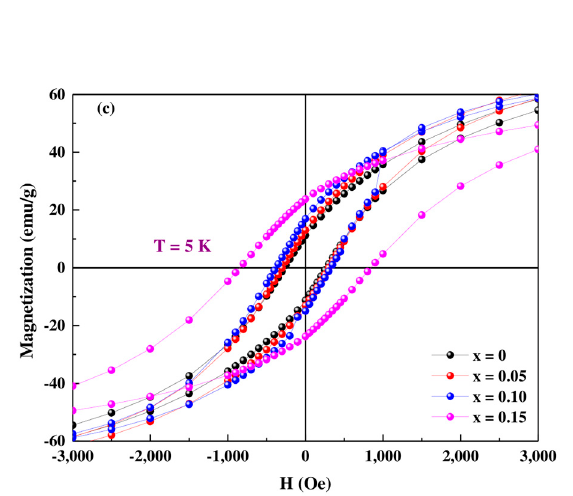
Figure 9. Magnetization curves versus applied magnetic field of Pr 0.7 Sr 0.3 Mn ( 1 − x ) Co x O 3 nanocrys- talline samples (0 ≤ x ≤ 0.15): ( a ). At 300 K ( b ) at 5 K ( c ). Enlarged region of the M(H) curves at 5K. Table 6. Values of saturated magnetization (Ms), coercivity Hc and residual magnetization Mr, at 5 K and 300 K for samples Pr (cid:2868).(cid:2875) Sr (cid:2868).(cid:2871) Mn ((cid:2869)(cid:2879)(cid:2934)) Co (cid:2934) O (cid:2871) (0 ≤ x ≤ 0.15). Composition